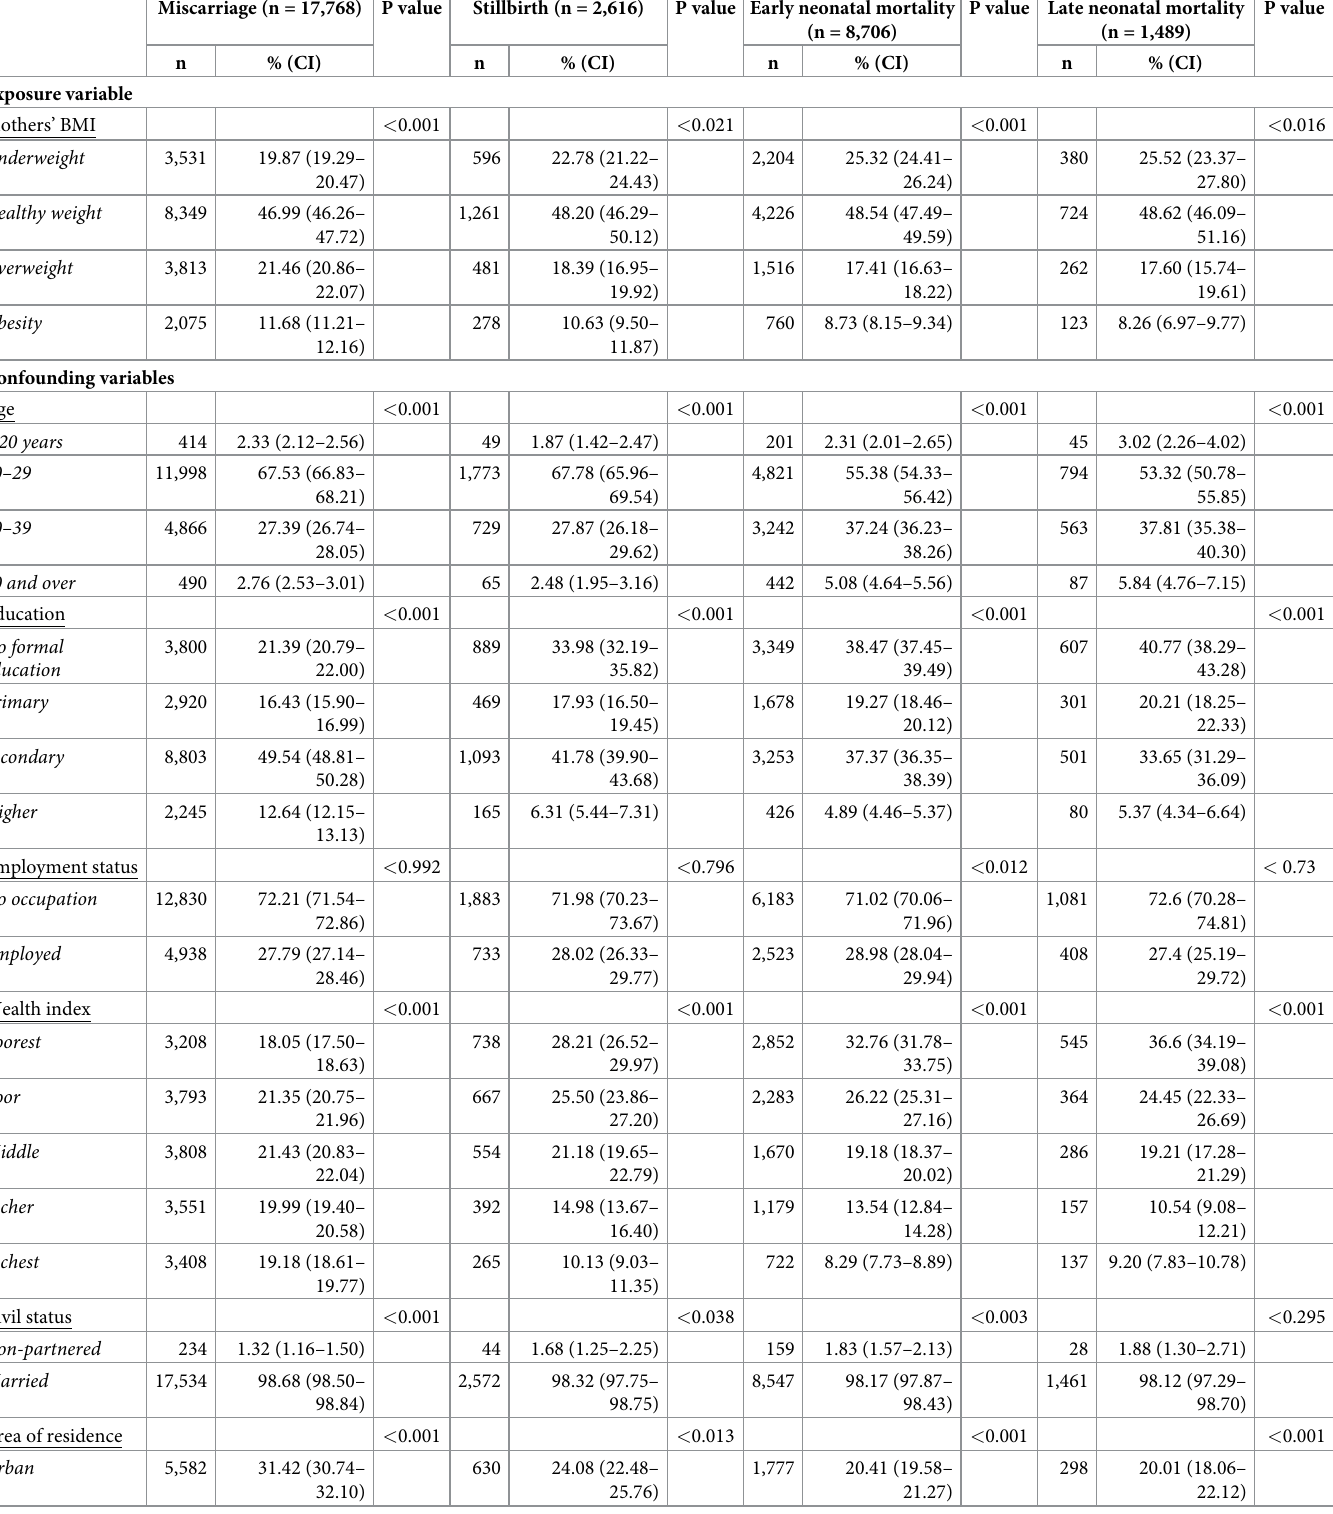
Table 2. Bivariate analysis between maternal obesity with fetal and neonatal death in the south and south-east Asia. Miscarriage (n = 17,768) P